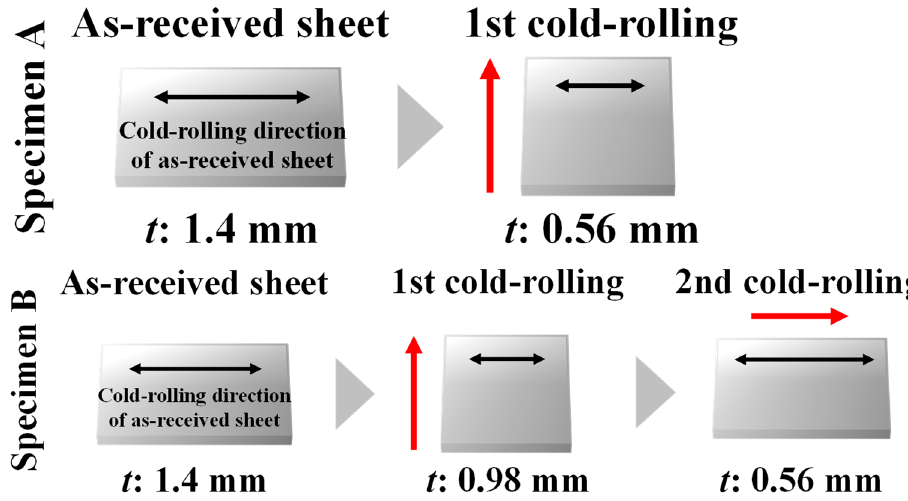
Figure 2. Schematics of cold-rolling conditions (red arrows: cold-rolling direction).